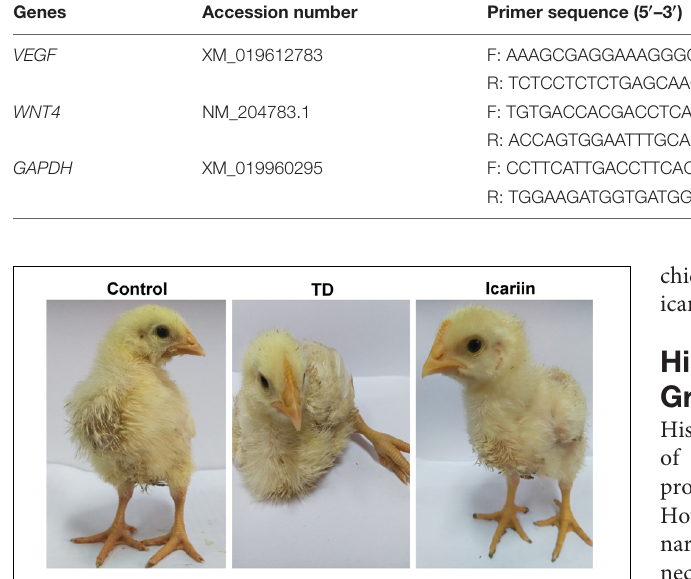
FIGURE 2 | Effects of icariin on thiram-induced tibial dyschondroplasia-dependent